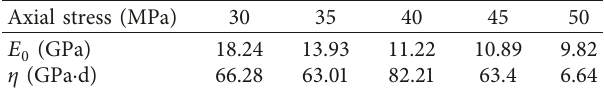
Figure 5: Axial creep of the specimens: (a) 30MPa; (b) 35 MPa; (c) 40MPa; (d) 45MPa; (e) 50MPa. Table 1: Specimen lateral creep parameters at every level of